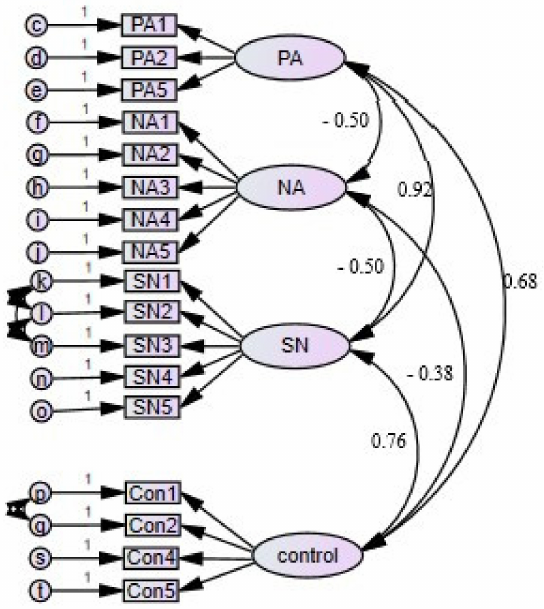
Figure 1. CFA of TPB items with standardized values for